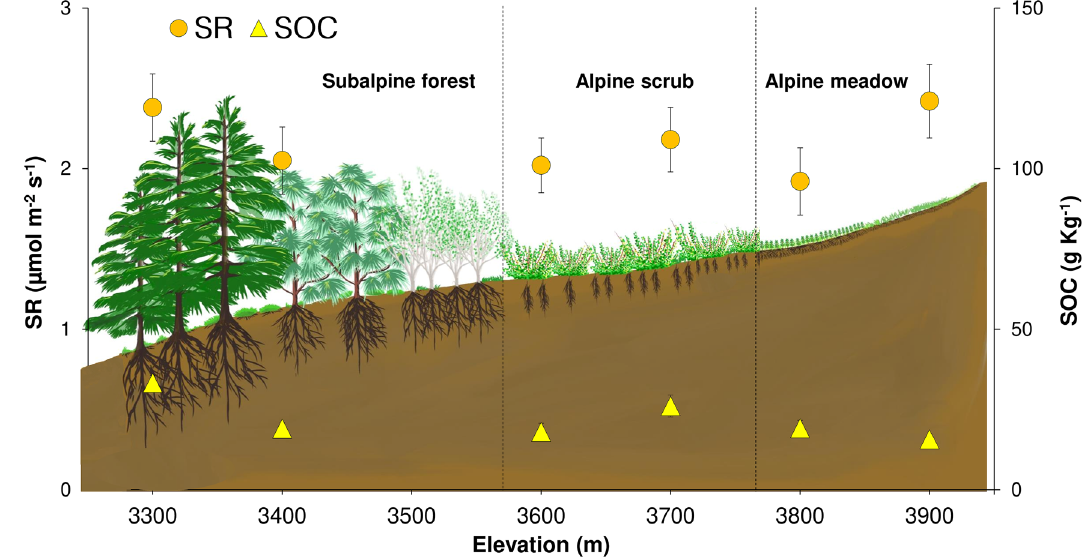
Figure 4. Equilibrium in SR and organic carbon across climosequence. Diagrammatic representation of a theoretical framework showing similar mean SR and soil organic carbon (SOC) at different elevations across climosequence and vegetation succession with n = 48. Note that vegetation changes from the subalpine forest (3300–3600 m) to alpine scrub (3600–3800 m) and alpine meadow (3800–4000 m) (Supplementary Table S1 online). Microsoft Excel 2019 (https:// www. micro soft. com/ en- us/ micro soft- 365/ micro soft- office) and Adobe Photoshop 7.0 (https:// www. adobe. com/ in/ produ cts/ photo shop. html) were used to prepare the graph and drawing,